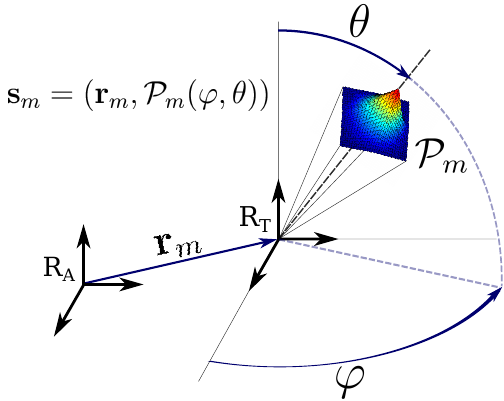
Figure 2. Muon tomography reference frame and notations. R A and R T respectively are the absolute orthonormal and the instrument reference frames. An observation axis s m = ( r m , P m (ϕ , θ )) is rep- resented with r m the vector that localizes the telescope position and P m its acceptance pattern (restrained to the solid angle (cid:127) m ). The spherical coordinates ( ϕ , θ ) here are localizing the steep acceptance peak mentioned in Sect. 3.1.